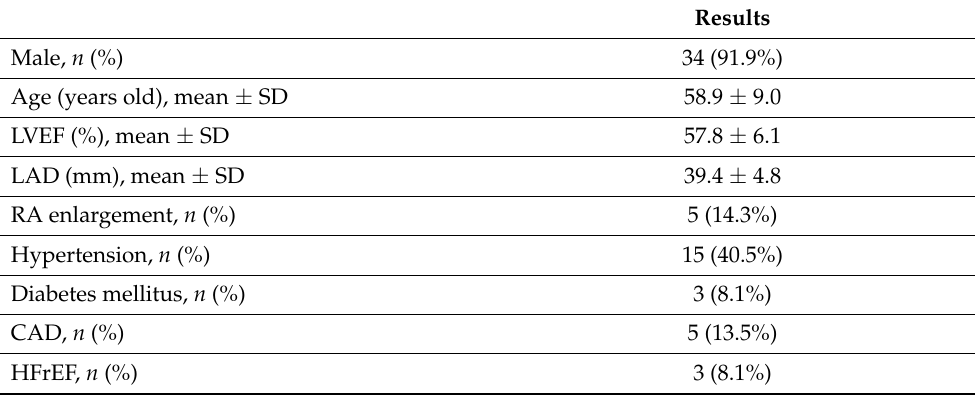
Table 1. Baseline characteristics in all patients ( n = 37).